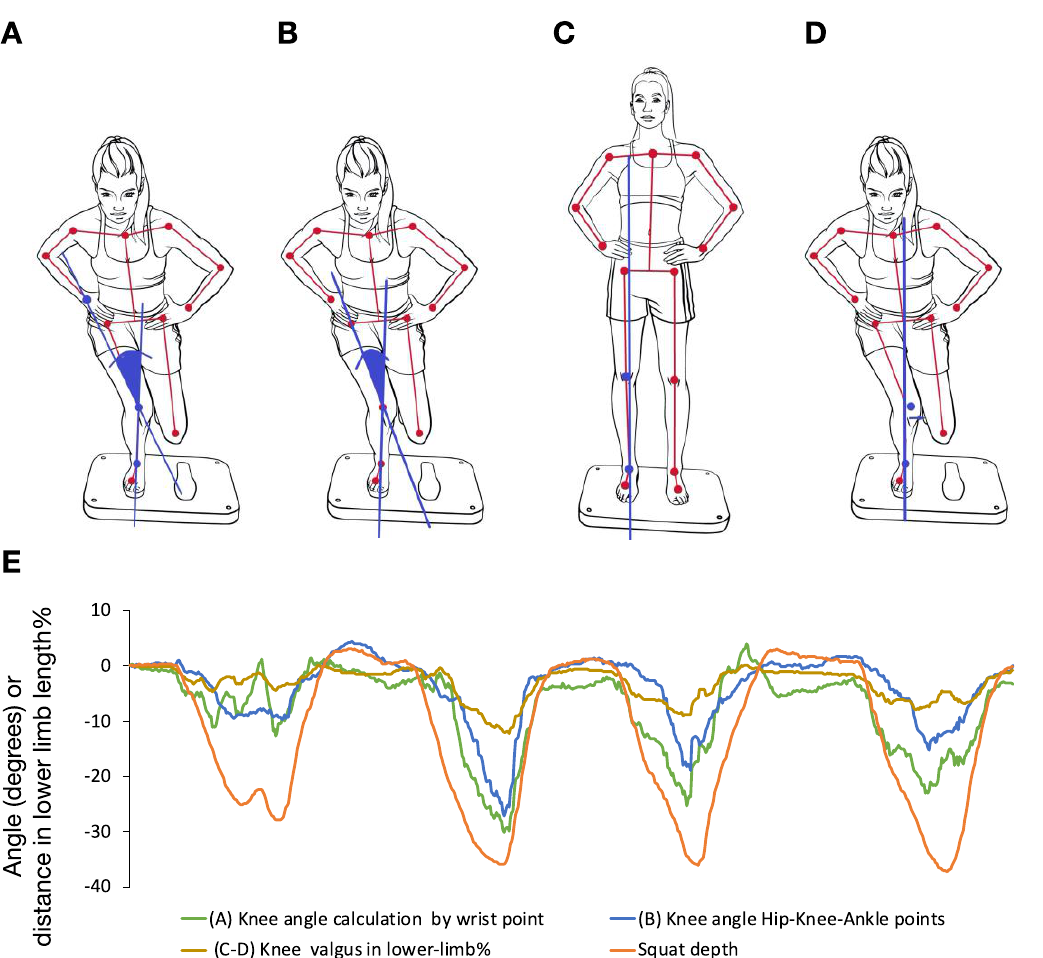
Figure 3. Different types of knee deviation calculations and squat depth changes under the single-leg squat test. Methods of knee valgus measurement. ( A ) Knee angle measurement is based on hip_X, knee_X and ankle_X coordinates. ( B ) Knee angle measurement is based on wrist_X, knee_X and ankle_X coordinates. ( C , D ) Knee valgus measurement is based on relative medial-lateral knee_X deviation compared to the standing position. Panel ( E ) shows four representative squats performed by a single subject evaluated by these methods simultaneously. Squat depth is also plotted as a reference. Note that using the Kinect wrist point as a reference for ‘hip’ is rather noisy (green line), while the hip-point based Q angle and the knee-over-foot lateral shift variables move more in parallel with each other.